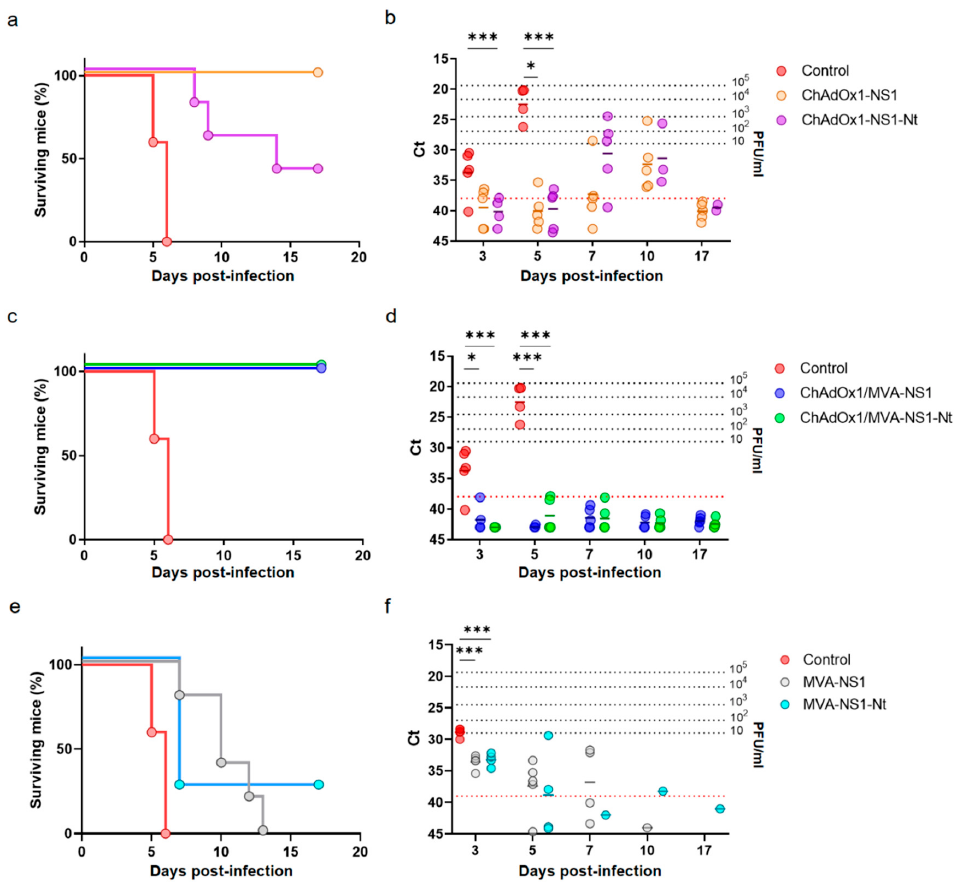
Figure 3. Protection of immunized IFNAR(- / -) mice against a lethal challenge with BTV-4M. Groups of 5 mice ( n = 5) were immunized with ( a , b ) a single dose of 10 8 IU per mouse of ChAdOx1-NS1 or ChAdOx1-NS1-Nt, ( c , d ) following a heterologous prime-boost regimen consisting of an initial dose of 10 8 IU per mouse of ChAdOx1-NS1 or ChAdOx1-NS1-Nt (prime) followed by a second dose of 10 7 PFU per mouse of MVA-NS1 or MVA-NS1-Nt (boost), respectively, administered 28 days apart, or ( e , f ) a single dose of 10 7 PFU per mouse of MVA-NS1 or MVA-NS1-Nt. Immunized and non-immunized mice were challenged with a lethal dose (10 PFU) of BTV-4M as described in Materials and Methods. ( a , c , e ) Survival rates after infection. Statistical di ff erences between the curves were calculated using Log-rank test. ( b , d , f ) Detection of BTV-4M in blood of non-immunized and immunized IFNAR(- / -) mice after challenge by RT-qPCR. Expression of mRNA of segment 5 (encoding NS1 protein) was quantified at 3, 5, 7, 10 and 17 d.p.i Results are expressed as Ct (left y-axis) and PFU equivalents (right y -axis and dotted horizontal lines). Cut-o ff Ct ≥ 38 (dotted pink line). Di ff erences between groups were calculated by multiple t test analysis using the Sidak–Bonferroni method. * p -value < 0.033; *** p -value < 0.001. Consecutively, in order to confirm that NS1 delivered by the viral vectors ChAdOx1 or MVA induces full multiserotype protection against BTV, IFNAR(-/-) mice were immunized with ChAdOx1- NS1 or ChAdOx1/MVA-NS1 or non-immunized and challenged with a lethal dose of BTV-8. Non- immunized animals showed viremia at day five after infection and all of them died by day seven post-challenge. In contrast, all animals immunized with ChAdOx1-NS1 or the heterologous prime- boost ChAdOx1/MVA-NS1 survived to the infection with BTV-8 (Figure 4a) and viremia was not detected at any time analyzed post-challenge (Figure 4b). These results confirm that immunization of IFNAR(-/-) mice with ChAdOx1-NS1 or ChAdOx1/MVA-NS1 confers protection against multiple serotypes of BTV.